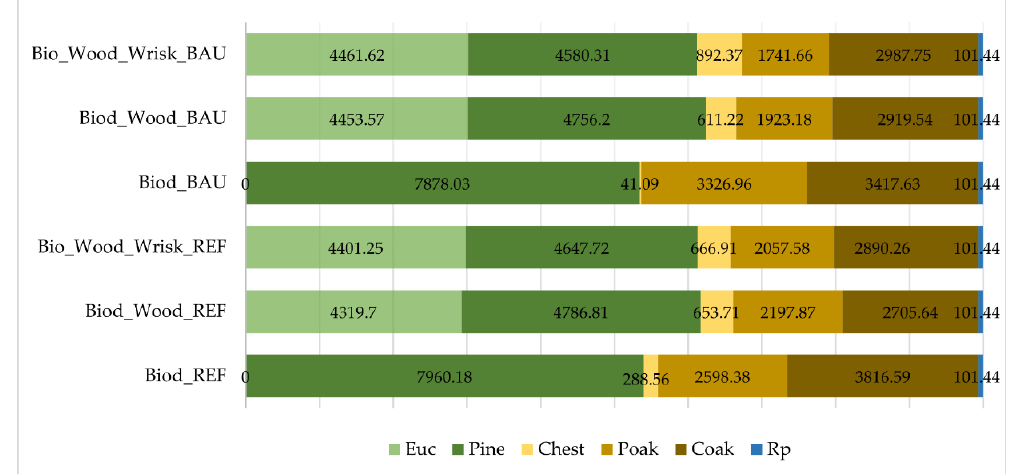
Figure 3. Landscape optimal area distribution (total area covers 14,765 hectares) per species and local-climate scenarios at the end of the planning horizon (90-years). (Euc: Eucalyptus globulus ; Pine: Pinus pinaster ; Chest: Castanea sativa ; Poak: Quercus robur ; Coak: Quercus suber , Rp: riparian